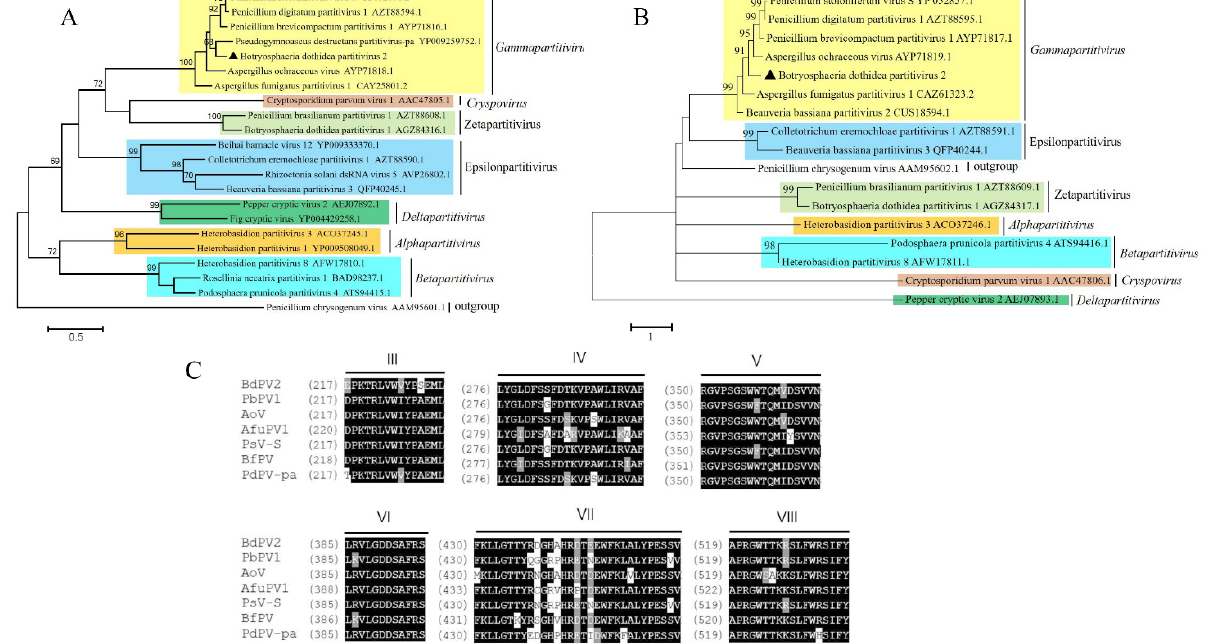
Figure 2. Phylogenetic analysis of BdPV2. Maximum-likelihood (ML) phylogenetic analysis based on amino acid sequences of ( A ) RdRp and ( B ) CP of BdPV2 and other selected members of seven genera of the Partitiviridae family. Phylogenetic tree was generated using MEGA 7 with 1000 bootstrap replicates. Triangle indicates position of BdPV2. ( C ) Multiple alignments of amino acid sequences of RdRp motifs of BdPV2 and other selected mycoviruses in Partitiviridae family. Six motifs (III–VIII) detected in conserved RdRp sequence. Similar amino acid residues are shaded in black.